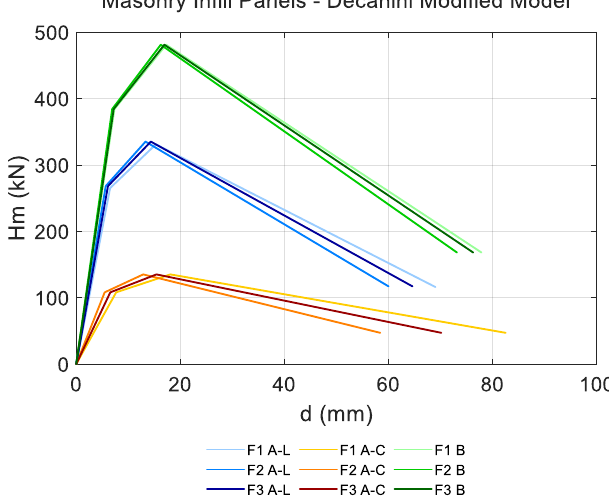
Figure 8. Case study masonry infill panels constitutive models.